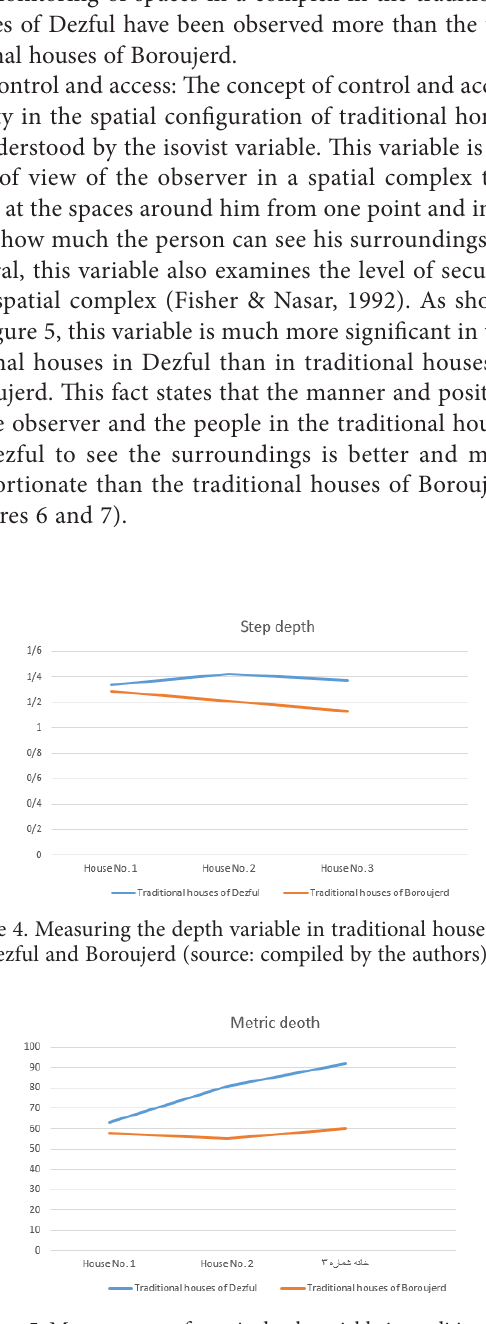
Figure 5. Measurement of metric depth variable in traditional houses of Dezful and Boroujerd (source: compiled by the